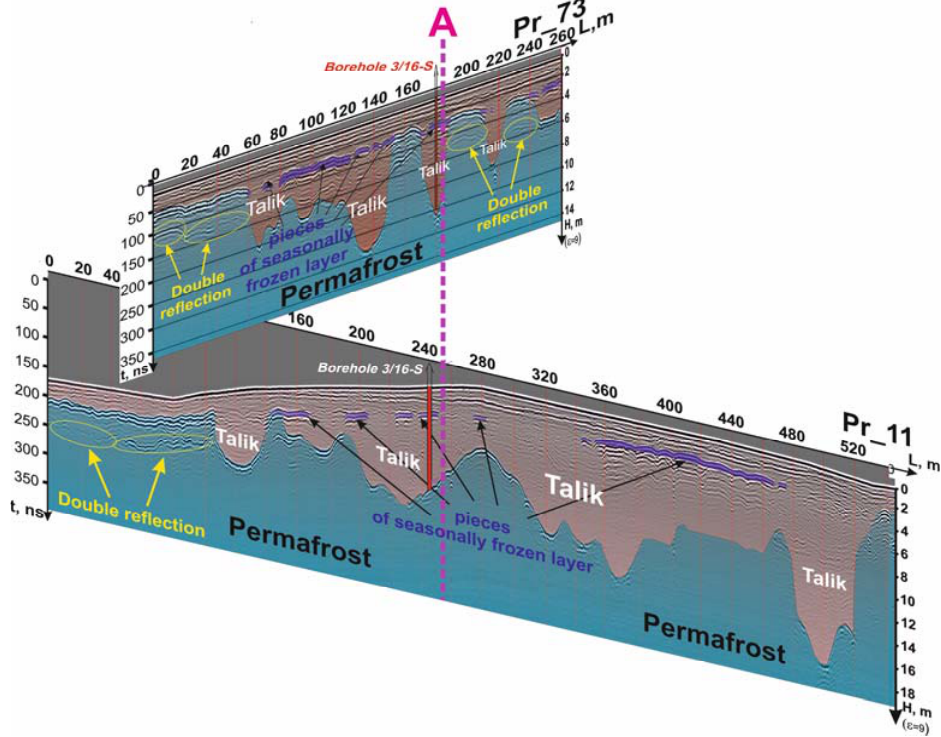
Figure 2. Pseudo-three-dimensional representation of taliks along two profiles according to GPR